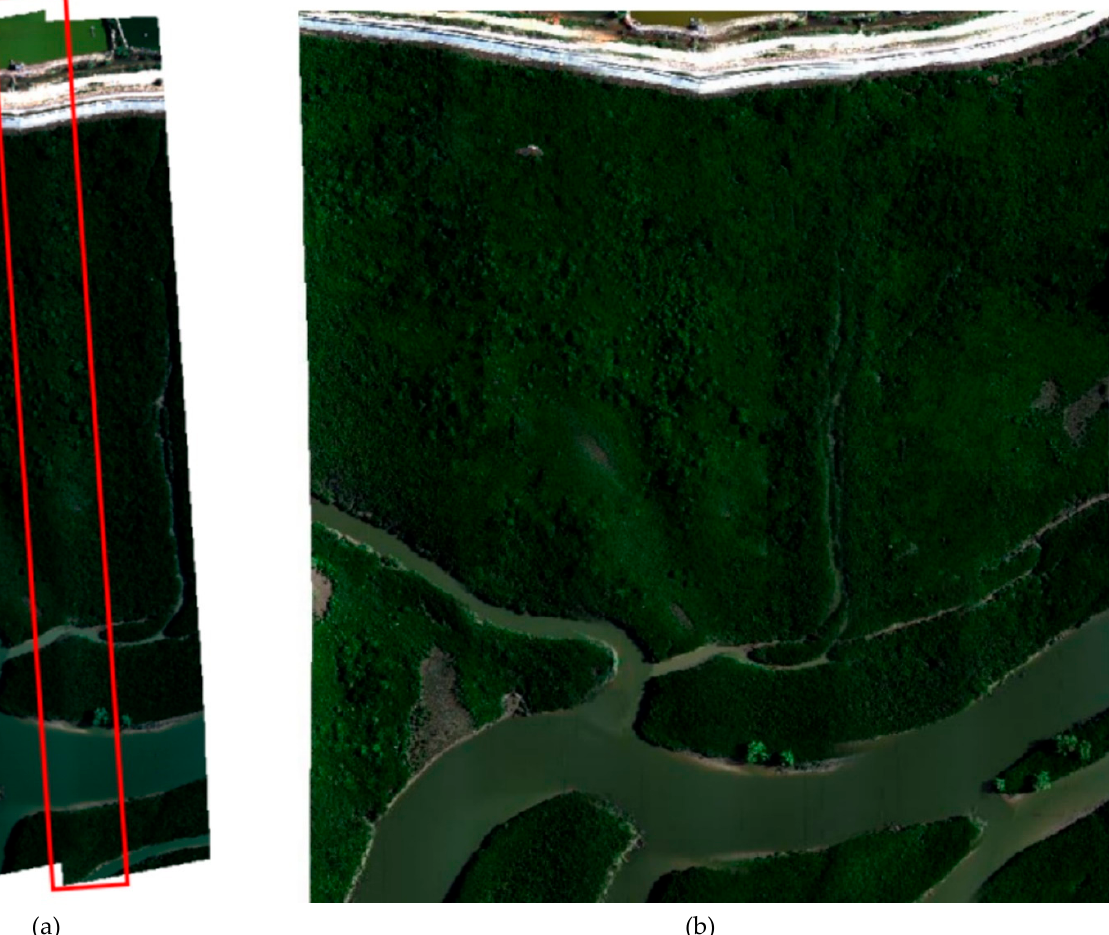
Figure 13. Forest experiment results: ( a ) the fused image by the weighted average method; and ( b ) the fused image of multiple forest image strips.